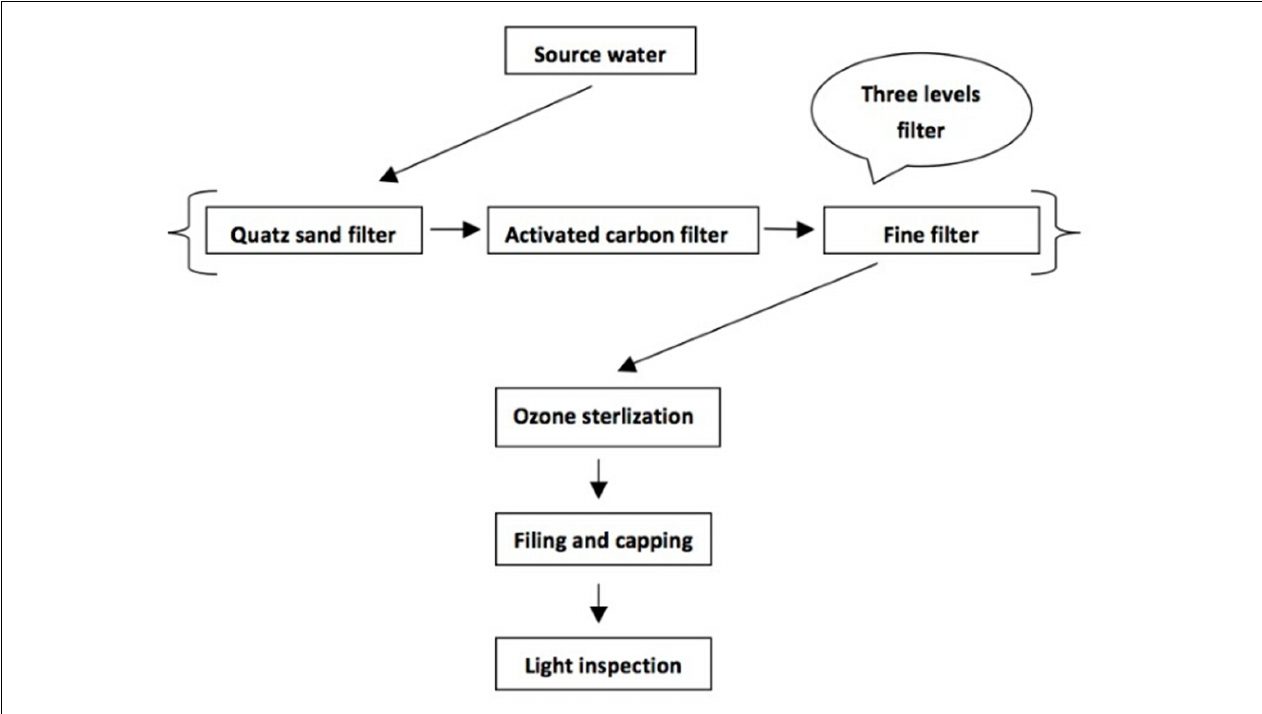
FIGURE 1 | Production flow chart of mineral water and spring water in China.